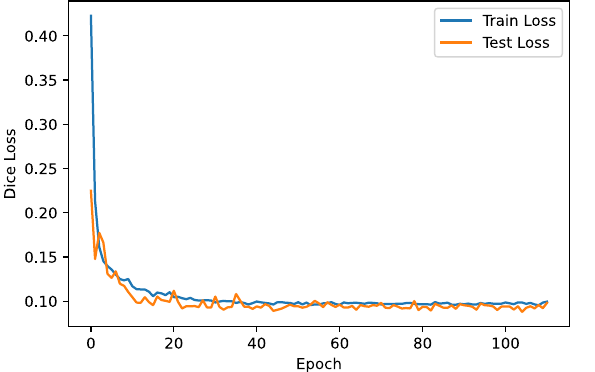
Figure 10. Training and Testing loss of the Expanded Patch model over the course of training. We can see that these curves have a similar trend, with the testing loss being more volatile, while remaining on target with training loss, indicating a good fit of the model.